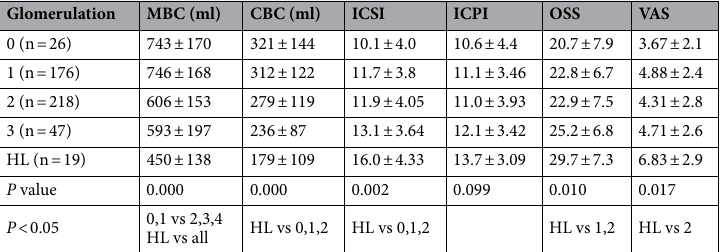
bladder pain (95/213, 44.6% vs. 113/191, 59.2%; P = 0.009). Similarly, the proportion of patients reporting a GRA score ≥ 2 was significantly lower among those with symptoms of difficult urination than in those without dysuria